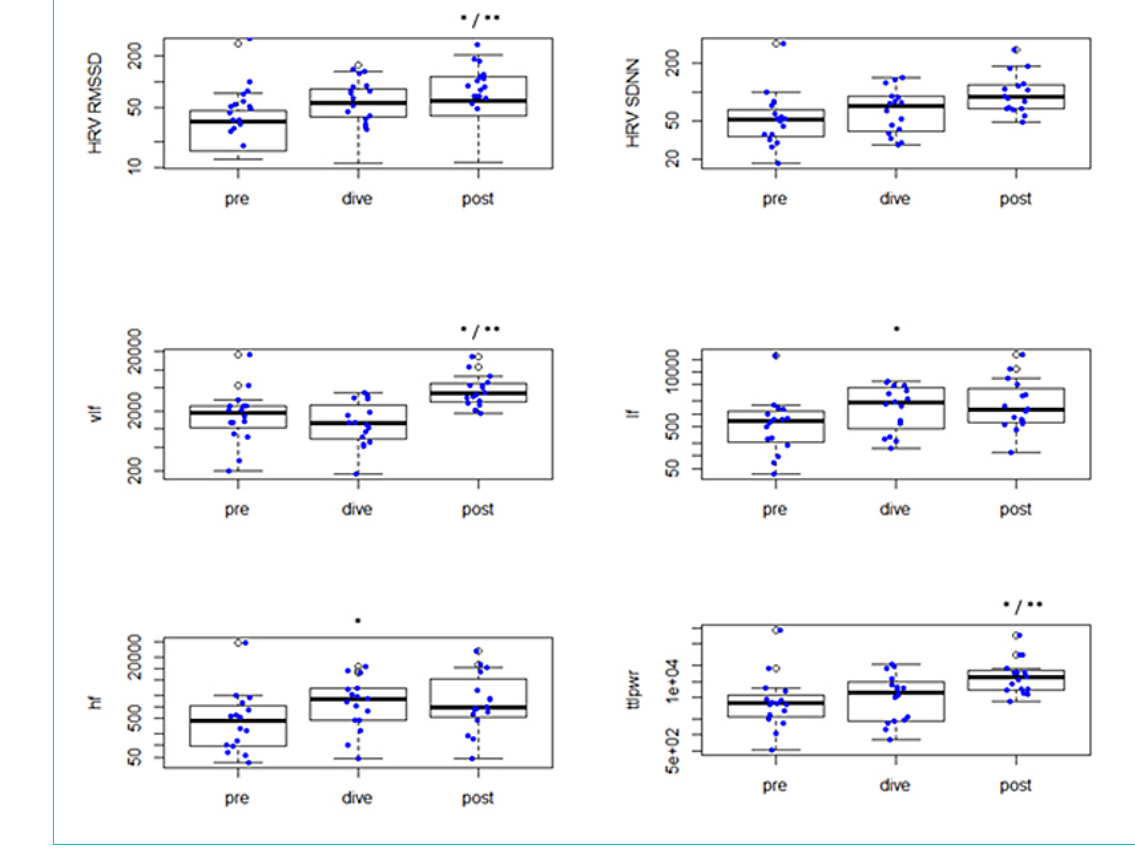
Figure 2: Changes in different HRV parameters before submersion (“pre”), during diving (“dive”) and after resurfacing (“post”). * Statistically significant different (p <0.05) compared with “pre” ** statistically significant different (p <0.05) compared with